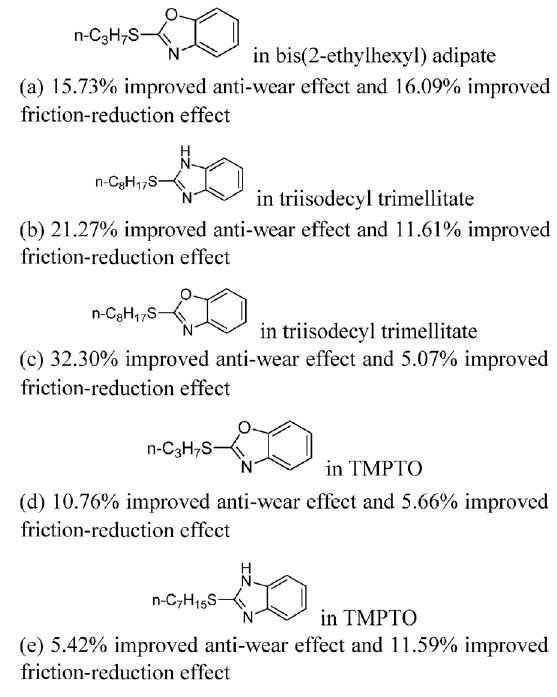
Fig. 30 The structural formula of the compound.